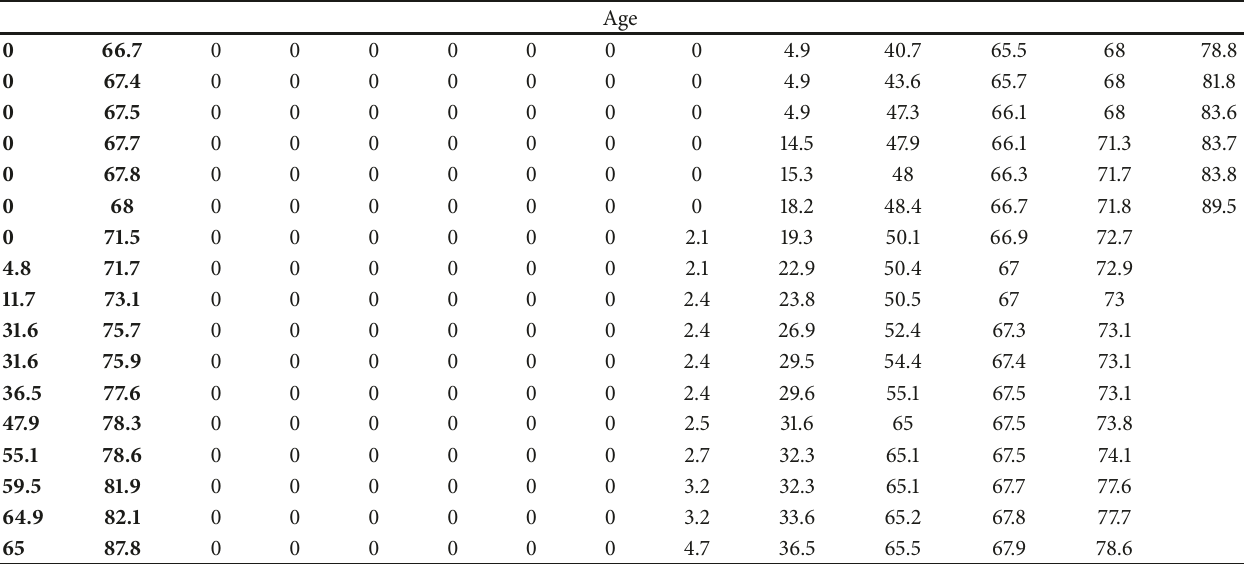
Table 1: The data table for the 227 sample units used for estimating the reliability. The listed values are the age of the unit at the testing time (measured in months) with the 34 units that failed bolded and listed in the first two columns. The remaining unbolded entries are the ages for units that passed.